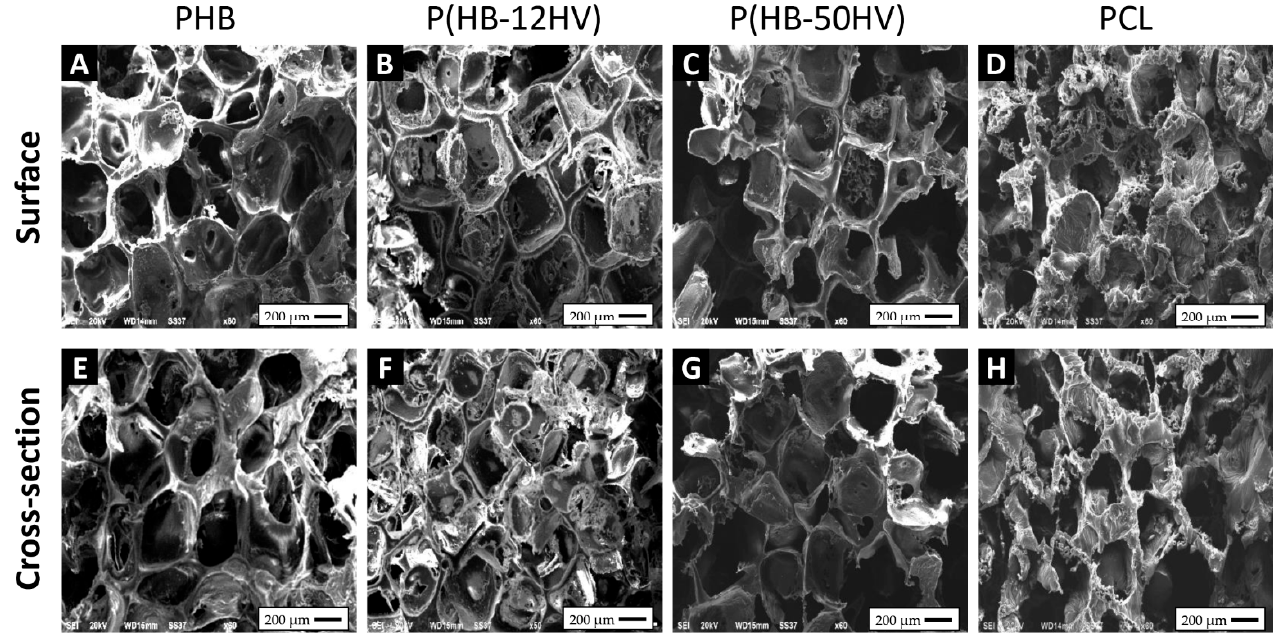
Figure 3. SEM micrographs of representative 3D porous scaffold samples with pore sizes ranging from 425 to 500 µm: PHB scaffold ( A , E ), P(HB-12HV) scaffold ( B , F ), P(HB-50HV) scaffold ( C , G ), and PCL scaffold ( D , H ).